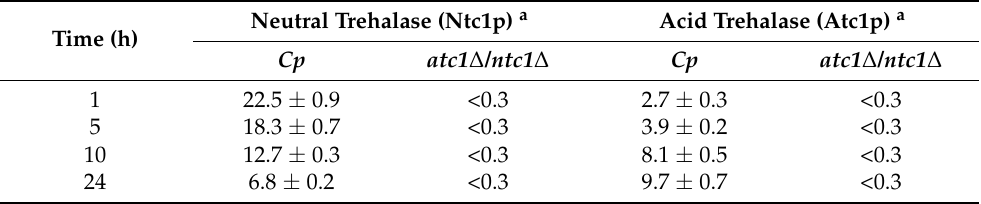
Table 1. Specific activities corresponding to neutral (Ntc1p) and acid (Atc1p) trehalases measured during growth in YPD displayed by the parental strain ( Cp ) and the trehalase-deficient null mutant ( atc1 ∆ /ntc1 ∆ ) of C. parapsilosis . Identical samples were harvested and prepared at the indicated intervals, and the enzymatic activities were measured as described in Methods. Results are the mean ± SD of one representative experiment of two performed in triplicate. Neutral Trehalase (Ntc1p) a Acid Trehalase (Atc1p) a Time (h) Cp atc1 ∆ /ntc1 ∆ Cp atc1 ∆ /ntc1 ∆ 1 22.5 ± 0.9 <0.3 2.7 ± 0.3 <0.3 5 18.3 ± 0.7 <0.3 3.9 ± 0.2 <0.3 10 12.7 ± 0.3 <0.3 8.1 ± 0.5 <0.3 24 6.8 ± 0.2 <0.3 9.7 ± 0.7